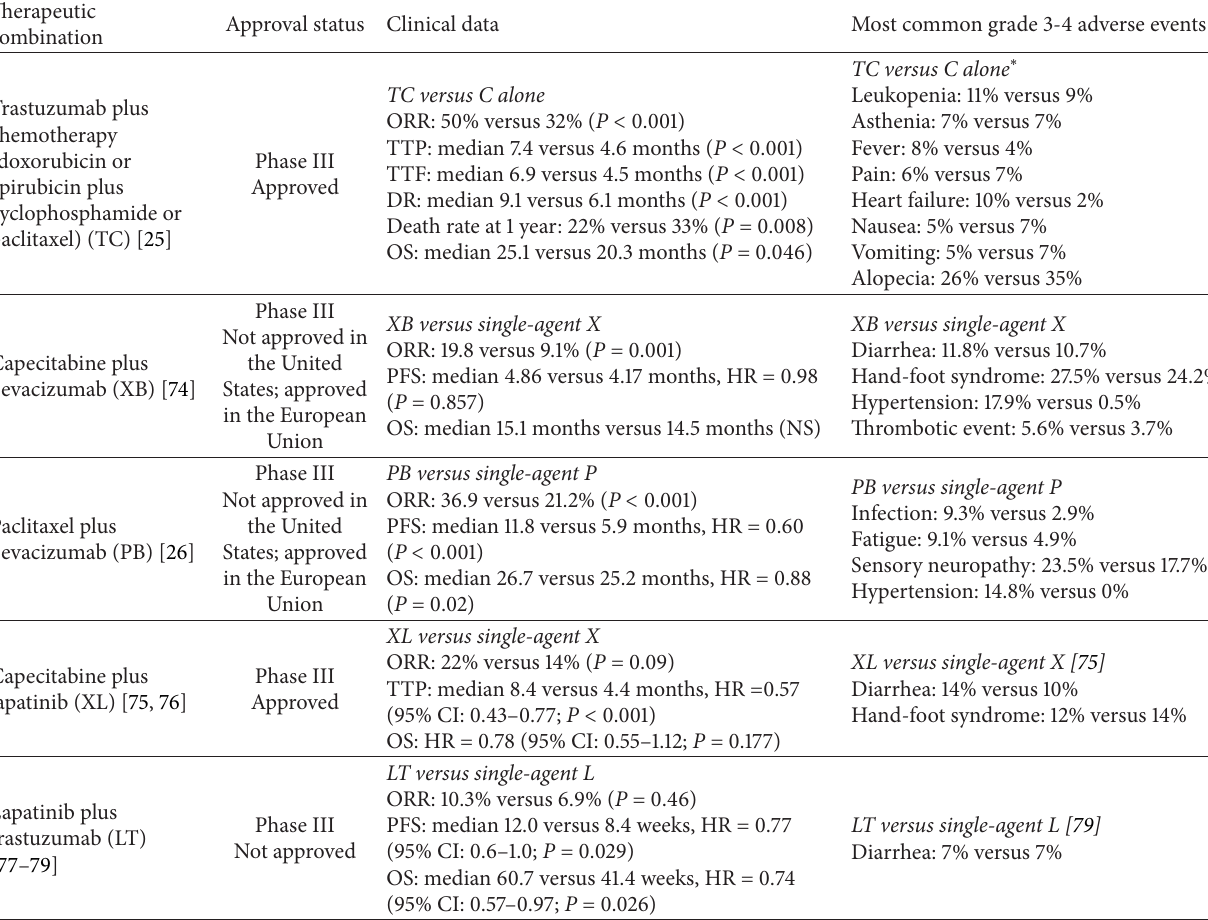
Table 2: Randomized combination cytotoxic plus targeted or biologic therapy for patients with